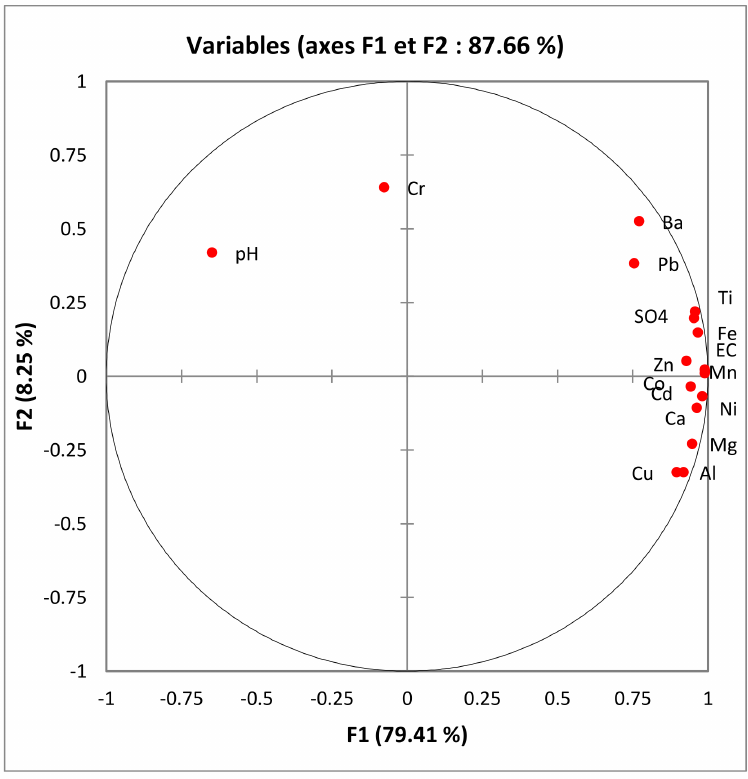
Figure 13. Principal component analysis for sampled water at the observation well T6: projection of variables on the plane F1-F2 (campaigns 1 to